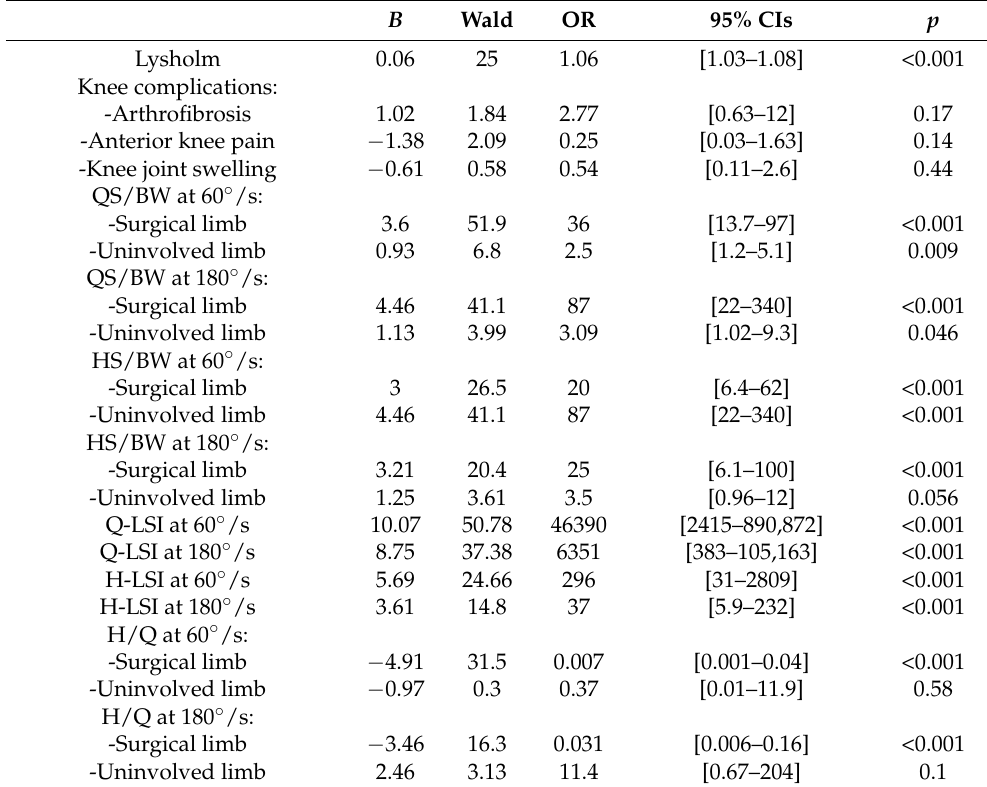
Table 3. Predictive parameters to return to running (univariate analysis).